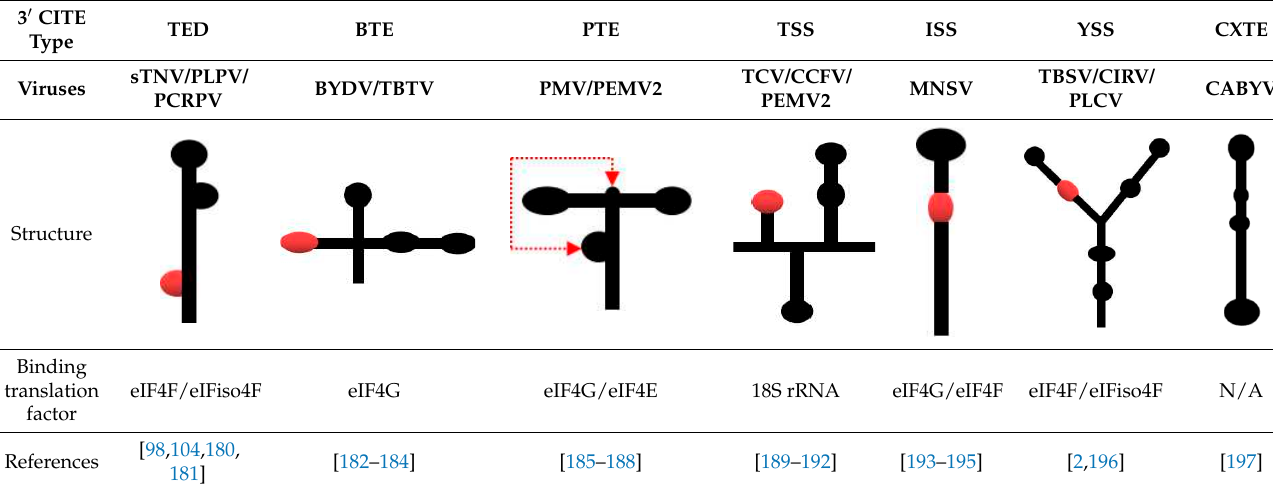
Table 3. Summary of 3 (cid:48) CITEes in plant RNA viruses. Table 3. Summary of 3 ′ CITEes in plant RNA viruses. Table 3. Summary of 3 ′ CITEes in plant RNA viruses. Table 3. Summary of 3 ′ CITEes in plant RNA viruses. Table 3. Summary of 3 ′ CITEes in plant RNA viruses. Table 3. Summary of 3 ′ CITEes in plant RNA viruses. Table 3. Summary of 3 ′ CITEes in plant RNA viruses. Table 3. Summary of 3 ′ CITEes in plant RNA viruses.